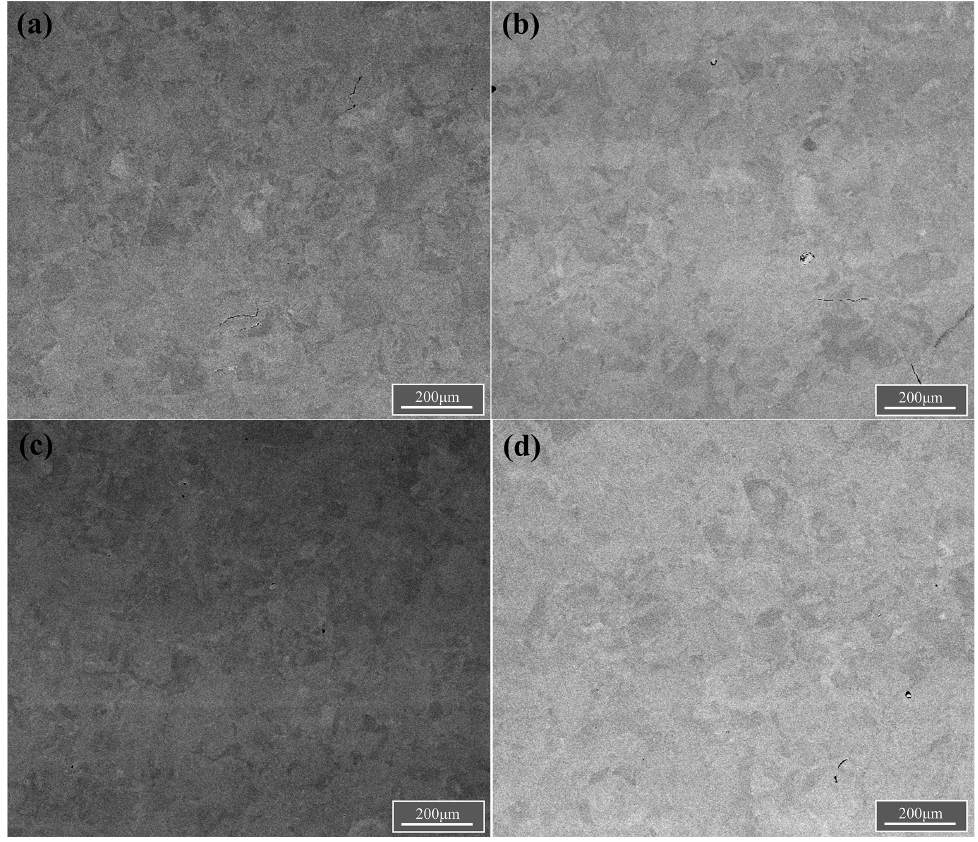
Figure 4. Microstructural characteristics of Ti-22Al-25Nb identified by SEM: ( a ) S1, ( b ) S2, ( c ) S3, and ( d ) S4.